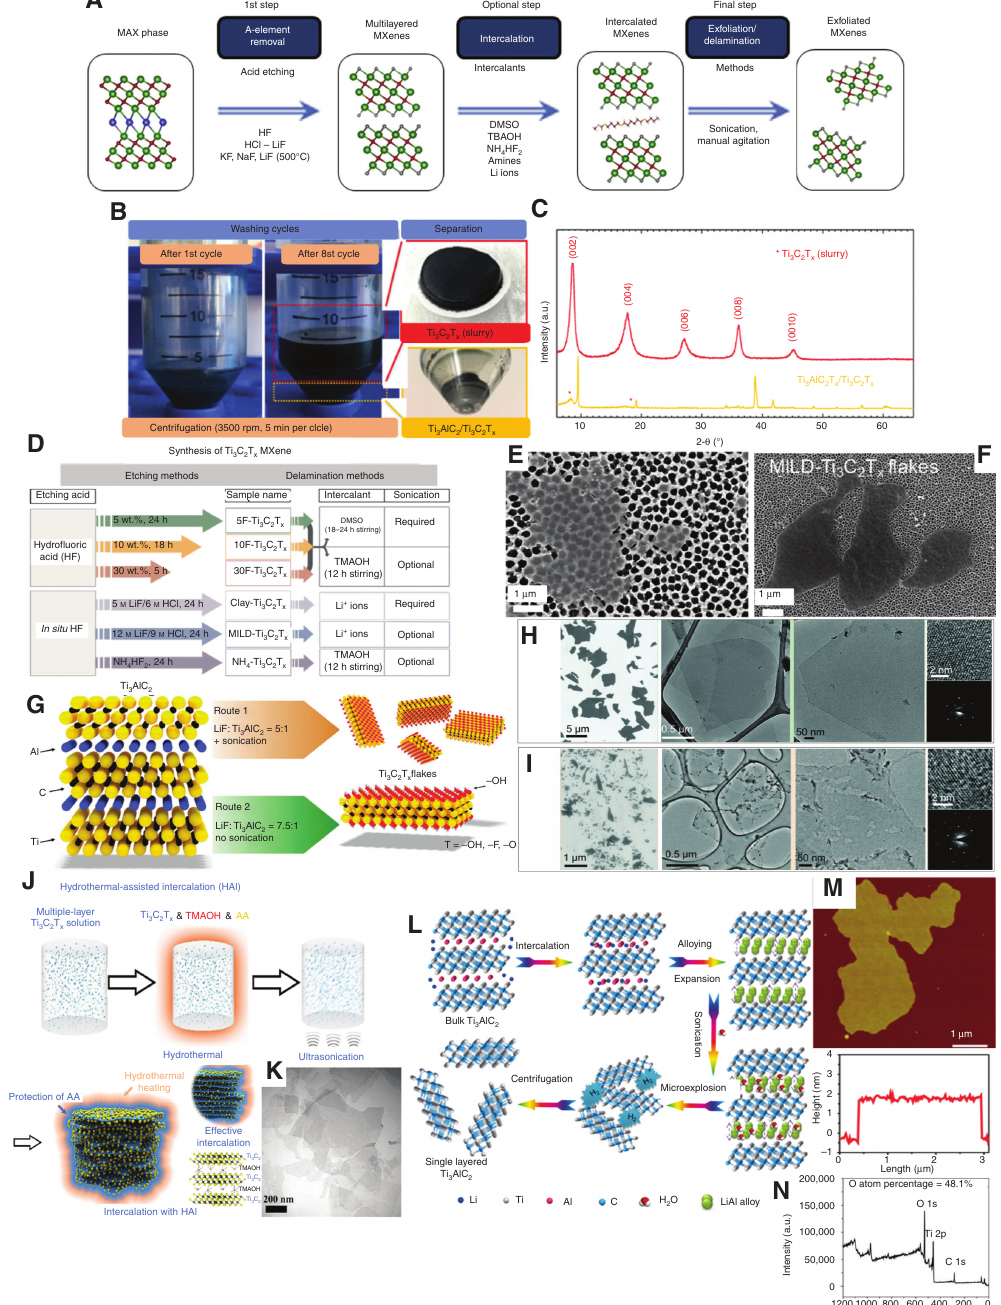
Figure 2: Liquid-phase processes for MXene synthesis and characterization of synthesized MXenes. (A) Schematic representation of liquid-phase process for MXene synthesis. (B) Image of MILD- Ti tube. After the eighth wash, two different layers were observed. The top is labeled as Ti labeled Ti AlC /Ti C T , is of a gray color. (C) XRD spectra of top layer of Ti 3 2 3 2 x liquid-phase synthesis process of Ti